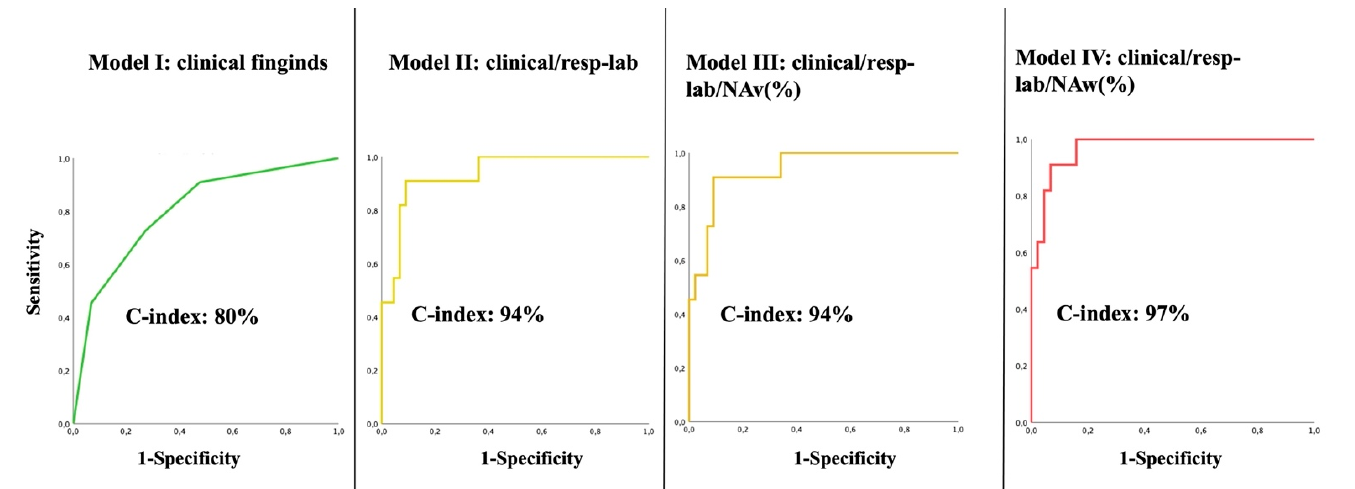
Figure 6. ROC analysis for Models I, II, III, and IV. Model I (clinical findings; green line) exhibited the lowest C-index (0.8; 95% CI: 0.66–95). Models II and III (Model I + respiratory/laboratoristic findings and Model II + NAv (%), respectively; yellow and orange lines) showed a similar C-index (0.94; 95% CI: 0.86–1). Model IV (Model II + NAw (%); red line) showed the highest C-index (0.97; 95% CI: 0.93–1). NAv (%): percentage of non-aerated lung volume; NAw (%): percentage of non-aerated tissue-weight. Table 3. Cox regression analysis.